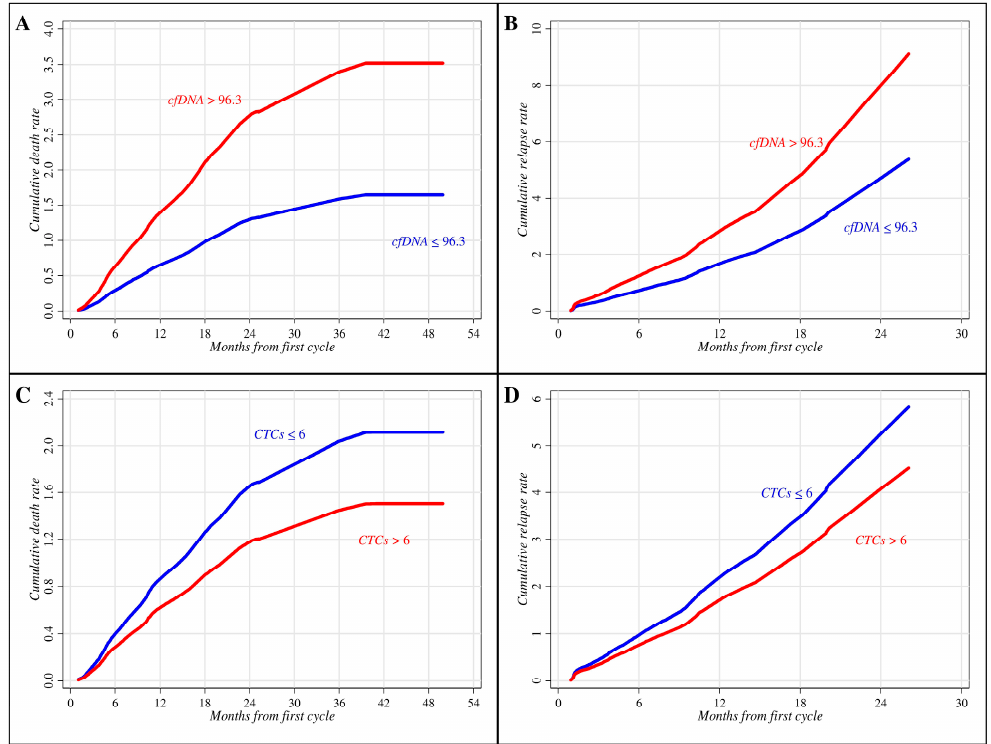
Figure 2. Curves of cumulative death and relapse rates according to cfDNA and CTCs by Cox regression modeling. Death ( A ) and relapse ( B ) rates estimated by cfDNA hTERT copy number. Death ( C ) and relapse ( D ) rates estimated by CTC number.